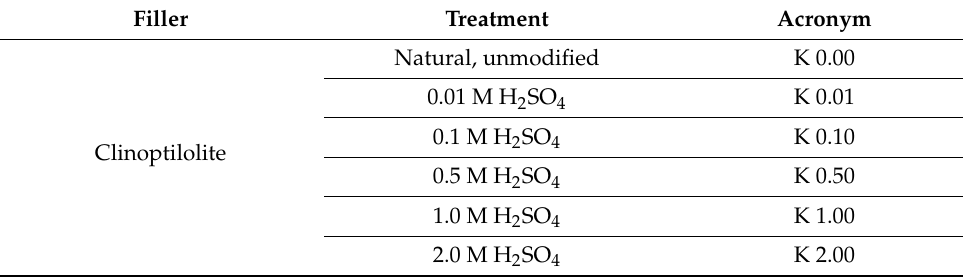
Table 1. Acronyms of natural and modified clinoptilolite. Filler Treatment